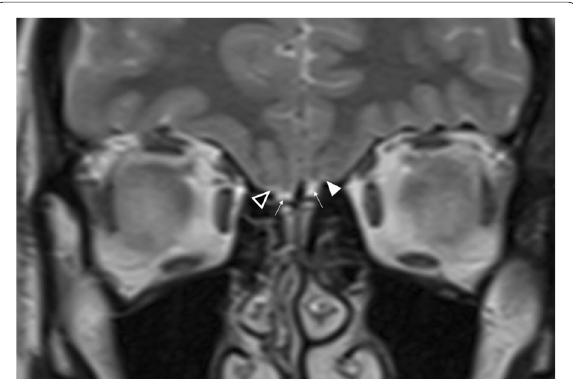
Fig. 10 18-year-old female presenting with no memory of ever having had a sense of smell. Coronal T2 weighted image demonstrates absence of the olfactory bulbs and olfactory tracts bilaterally (arrowed). There is additional blunting of the right olfactory sulcus (black arrowhead with white outline) whilst the left olfactory sulcus is preserved (arrowhead). The history and imaging findings are consistent with congenital